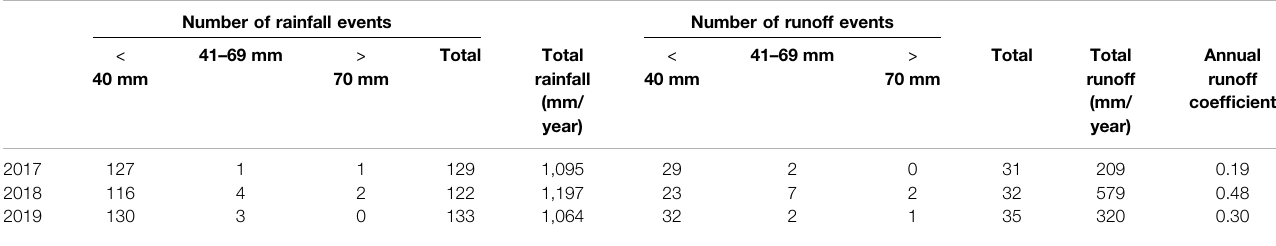
TABLE 5 | Rainfall classi fi cation and average annual runoff information for the study period. Number of rainfall